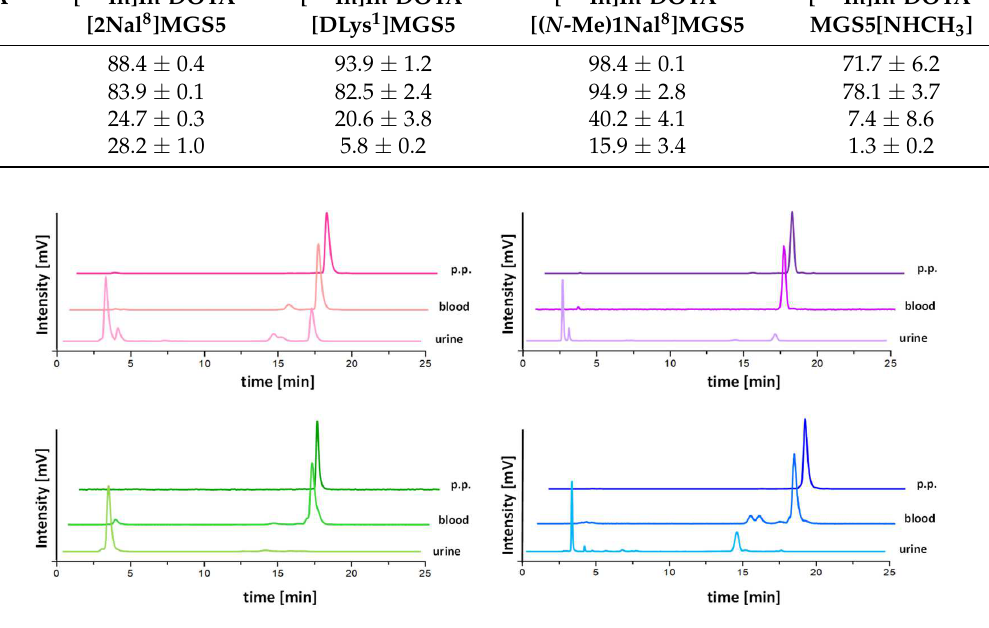
Figure 3. Representative radiochromatograms of the 111 In-labeled peptides post preparation (p.p.), as well as blood and urine samples obtained from BALB/c mice 10 min p.i. Pink: DOTA-[2Nal 8 ]MGS5, green: DOTA-[DLys 1 ]MGS5, purple: DOTA-[( N -Me)1Nal 8 ]MGS5, blue: DOTA-MGS5[NHCH 3 ].